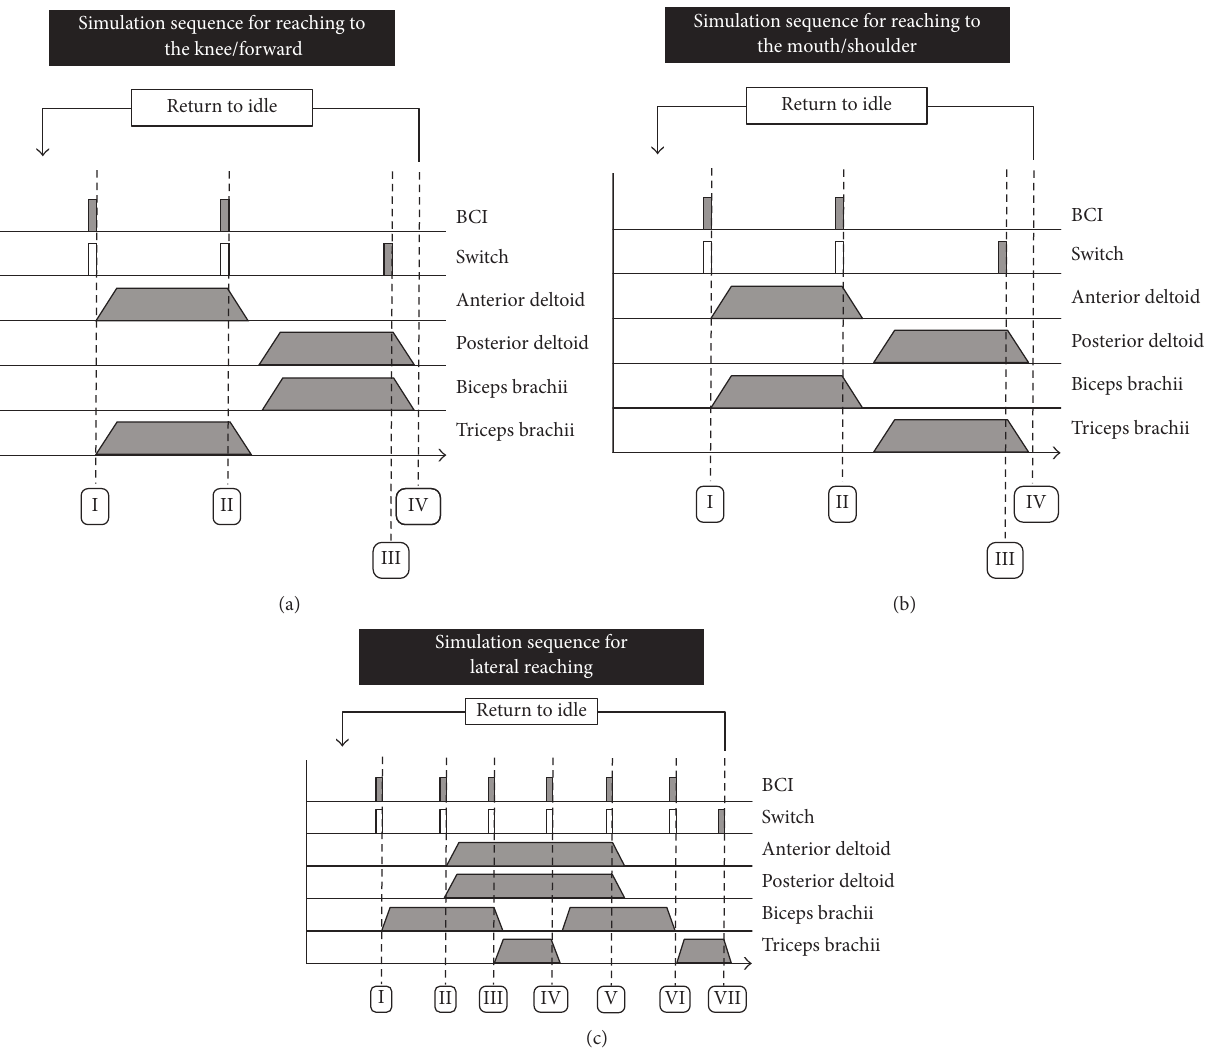
Figure 1: Stimulation sequences to facilitate (a) reaching to the right knee/forward, (b) reaching to the mouth/right shoulder, and (c) lateral reaching. For all sequences, activation of the BCI or switch would produce transition into the next phase of the movement. Empty rectangles in the “switch” component indicate optional